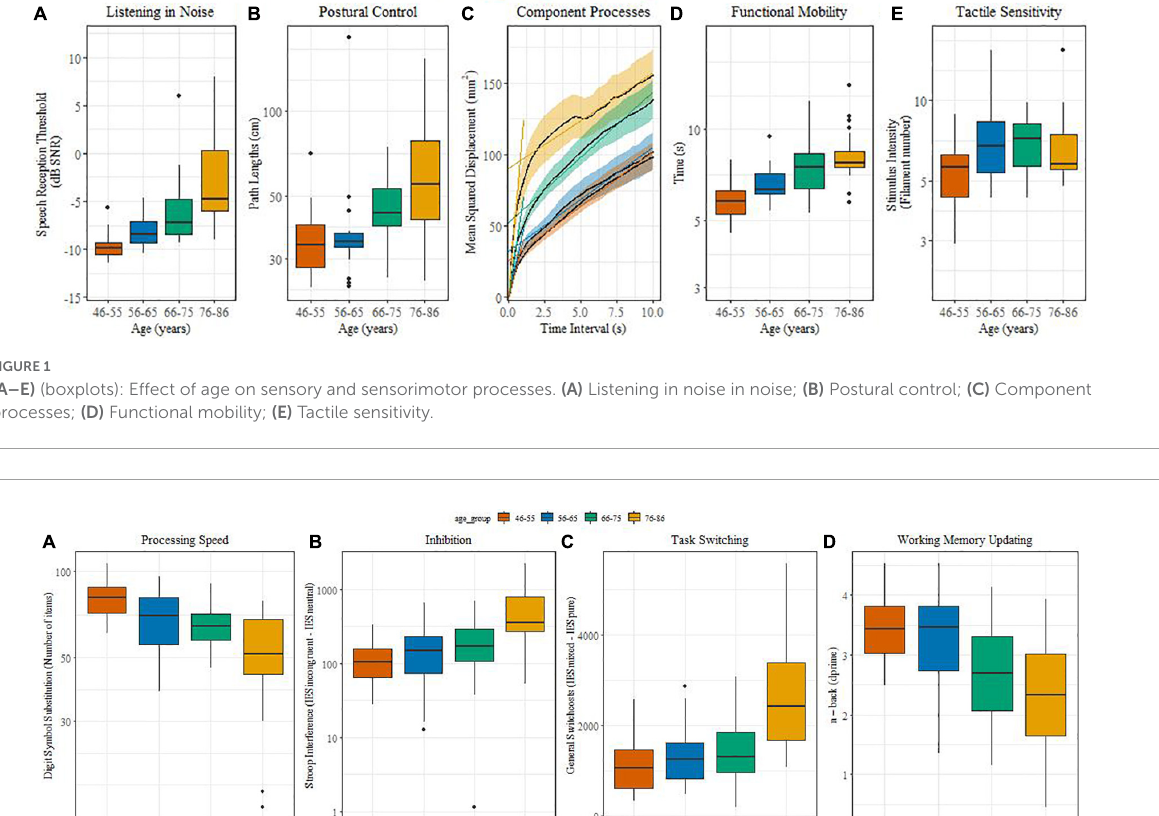
the middle-age groups of 46-55 and 56-65 ( β = 0.11, SE = 0.03, t = 3.4, p =